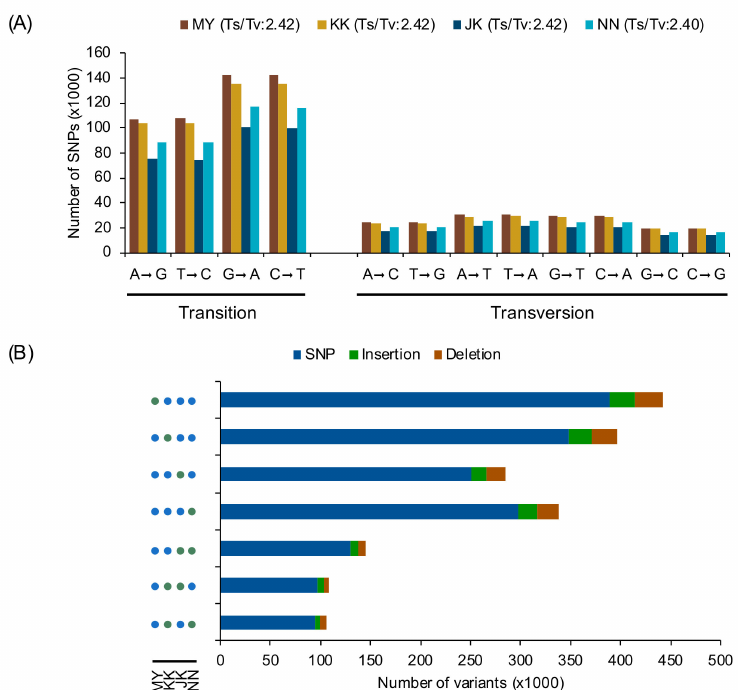
Figure 3. ( A ) Nucleotide substitution frequency of each rice genome as determined by SnpE ff [36]. ( B ) Number of variants in each LYR and HYR variety. Green and blue circles indicate that corresponding varieties share the variants. MY: Ma Yom, KK: Khitom Khao, JK: Jao Khao, NN: Nahng